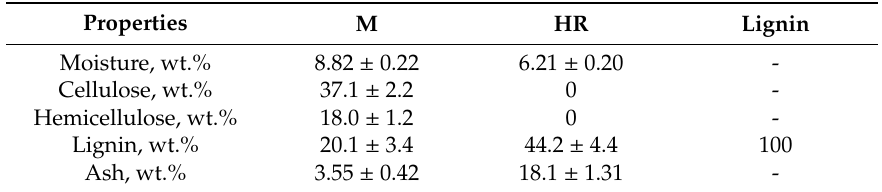
Table 1. The composition of Miscanthus (M), hydrolysis residue (HR) and lignin. * calculated by di ff